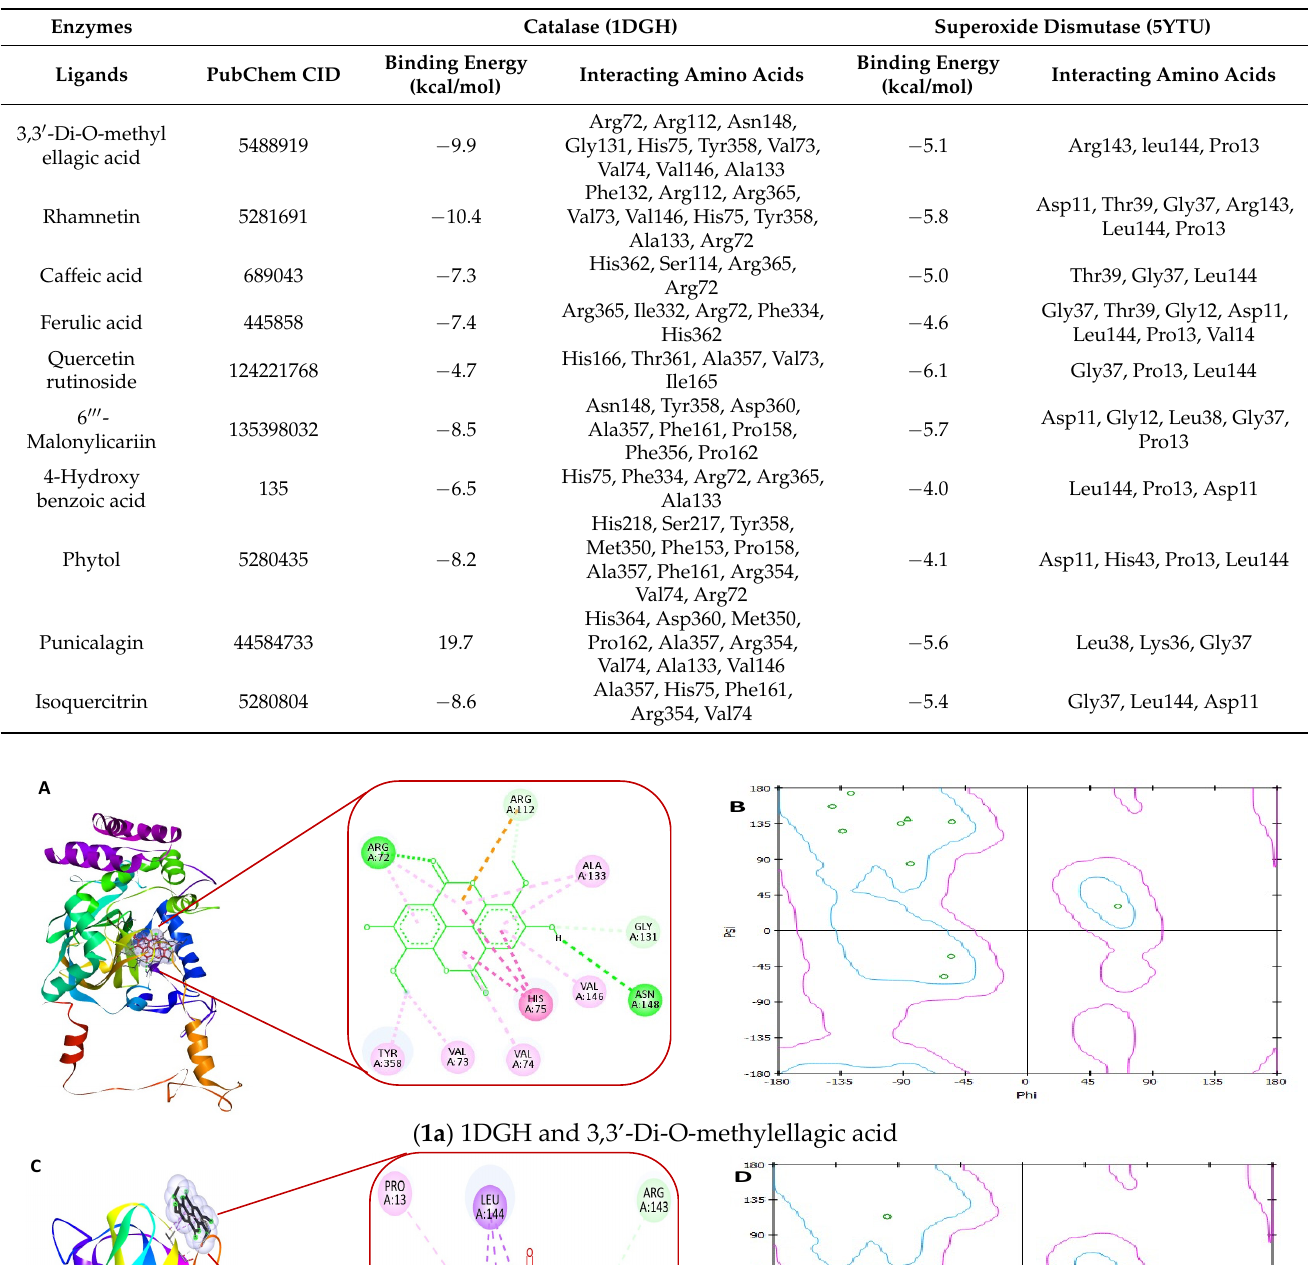
Table 5. Details of molecular docking study; the ligands, binding energy, and interacting amino acids interacting with receptors (1DGH and 5YTU).